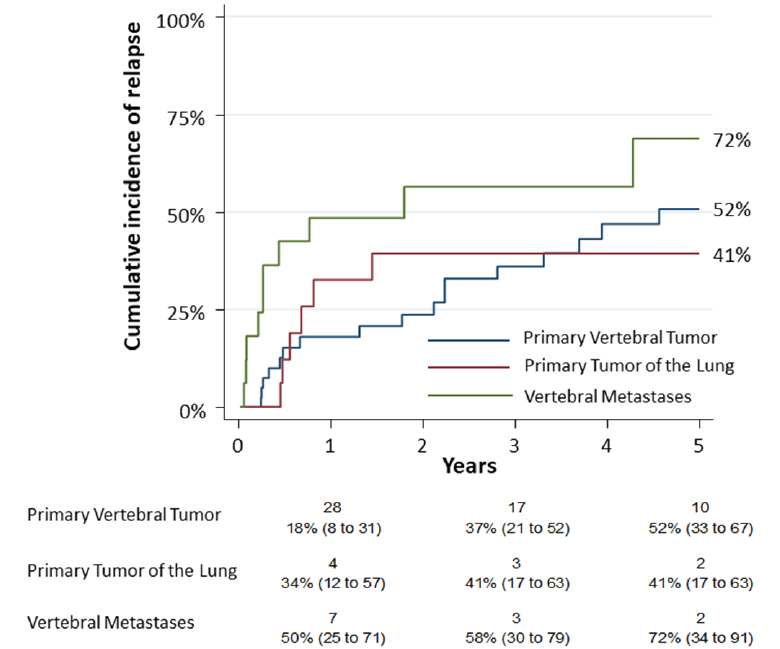
Figure 3. The cumulative incidence of relapse (CIR) among the different tumor groups resulted 52% (95% CI: 0.33–0.67) for primary vertebral tumors (group 1), 41% (95% CI: 0.17–0.63) for primary tumors of lung infiltrating spine (group 2) and 72% for vertebral metastases (group 3) (95% CI: 0.34–0.91). Numbers below the time axis are patients at risk and cumulative incidence estimates (95% CI).